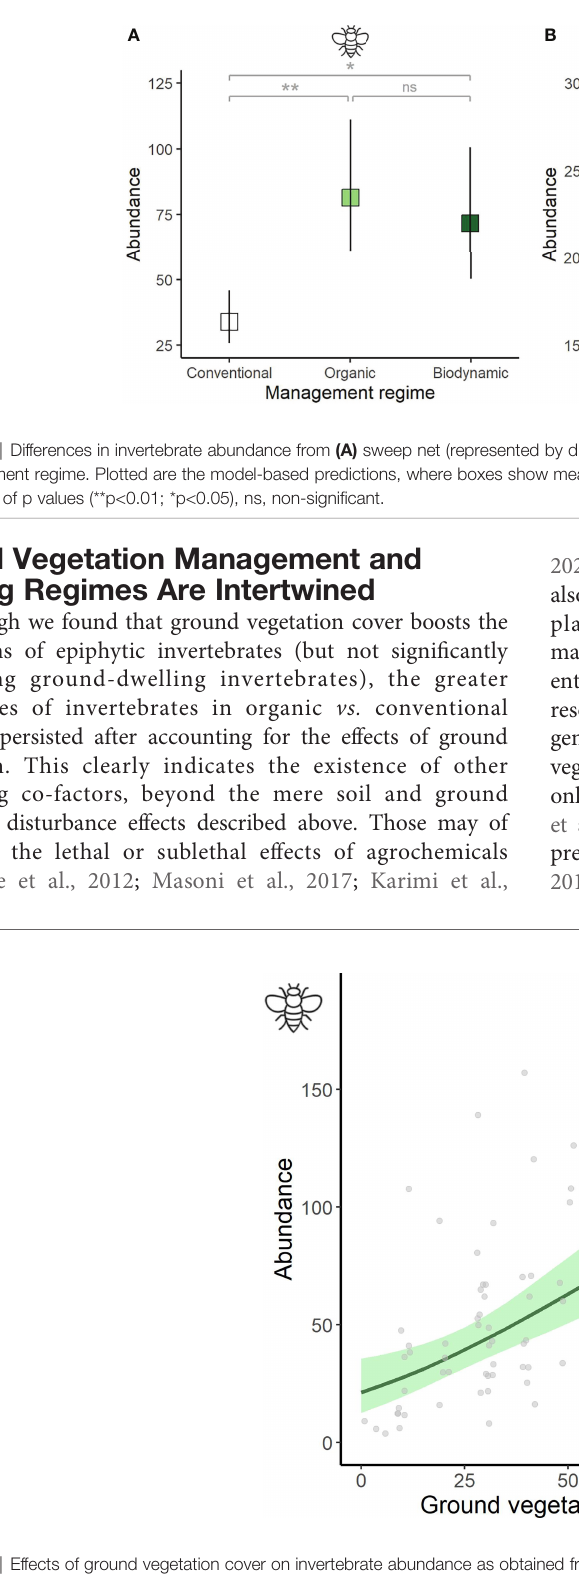
FIGURE 3 | Effects of ground vegetation cover on invertebrate abundance as obtained from the additive model based on with sweep-netting samples (epiphytic invertebrates represented by dipterans). Plotted are model-predicted means (solid line), 95% con fi dence intervals (shaded area) and raw data points (grey